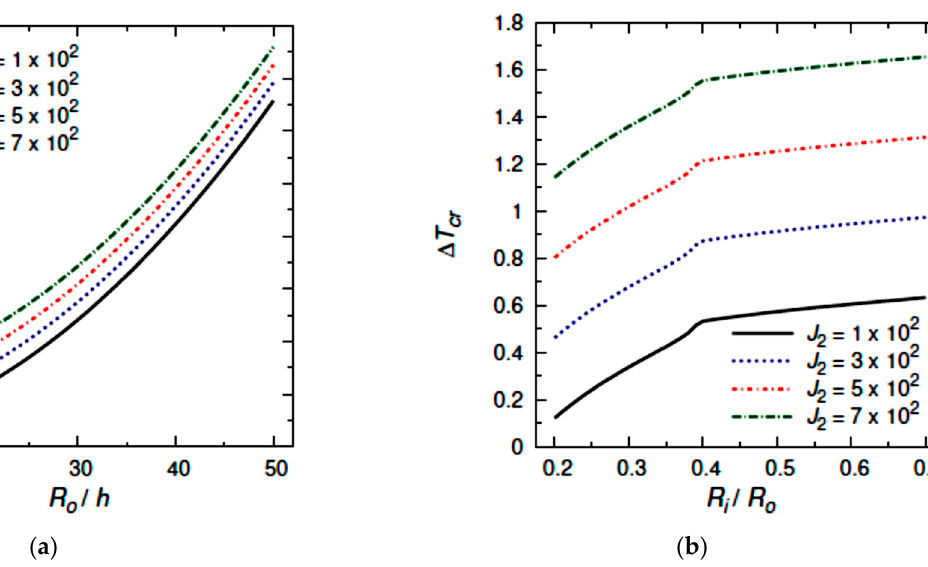
Figure 7. Critical buckling temperature ∆ T cr of simply supported SGP annular plates versus ( a ) the outer radius to thickness ratio R o / h and ( b ) inner radius to outer radius ratio R i / R o for different values of Pasternak’s coefficient J 2 ( κ = 1, E ζ = 10 3 V/m, ∆ C = 0.5%, e 0 = 10, w g = 0.1%, µ = γ = 2 nm, J 1 = 10 3 ).